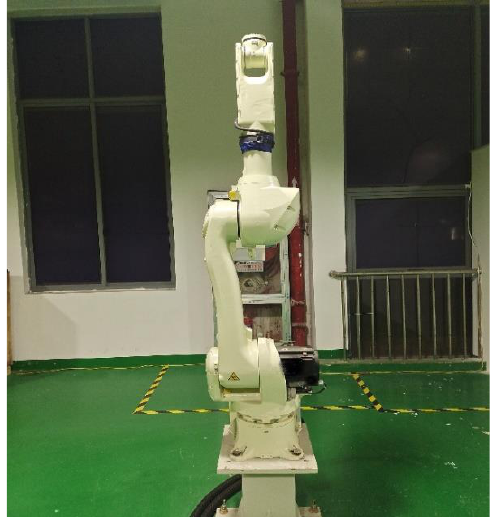
Figure 1. Schematic diagram of robot sampling site.